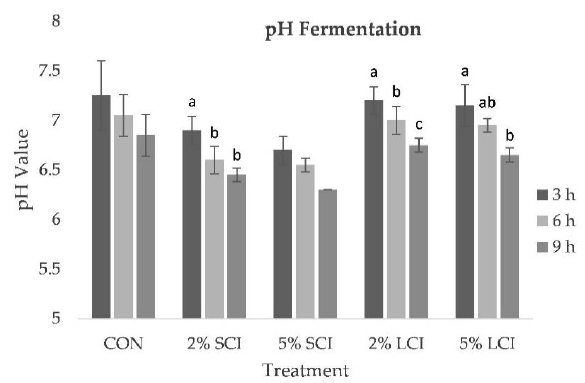
Figure 1. pH values of the five almond beverage treatments taken at 3, 6, and 9 h of fermentation. CON, control; SCI, short chain inulin; LCI, long-chain inulin). Means with different letters in the same group indicate significant differences between measurement times ( p < 0.05).